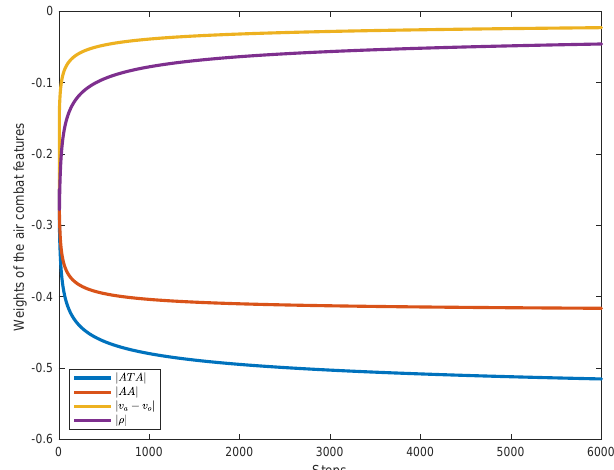
Figure 7. The convergence curve of weight w of the linear combination of aerial combat features.